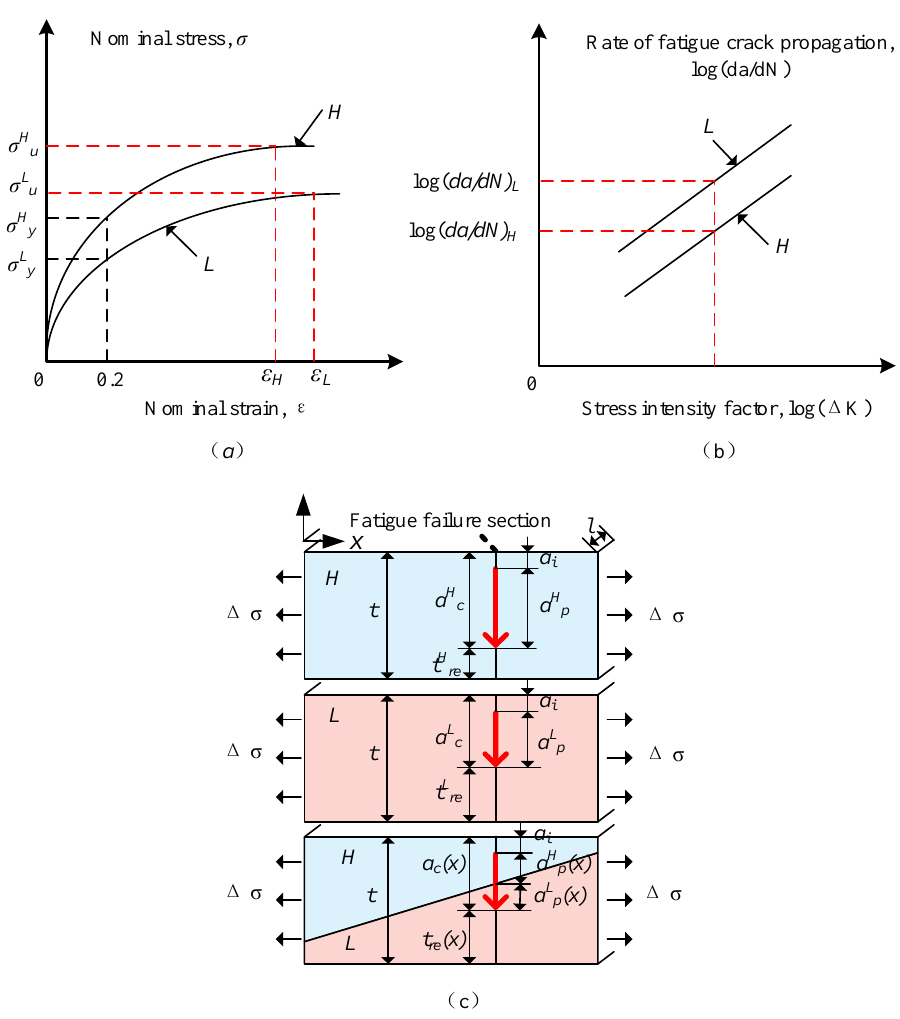
Figure 3. ( a ) Static performance of H and L ; ( b ) Fatigue crack growth properties of L and H ; ( c ) Fatigue failure process of heterogeneous and homogeneous materials.